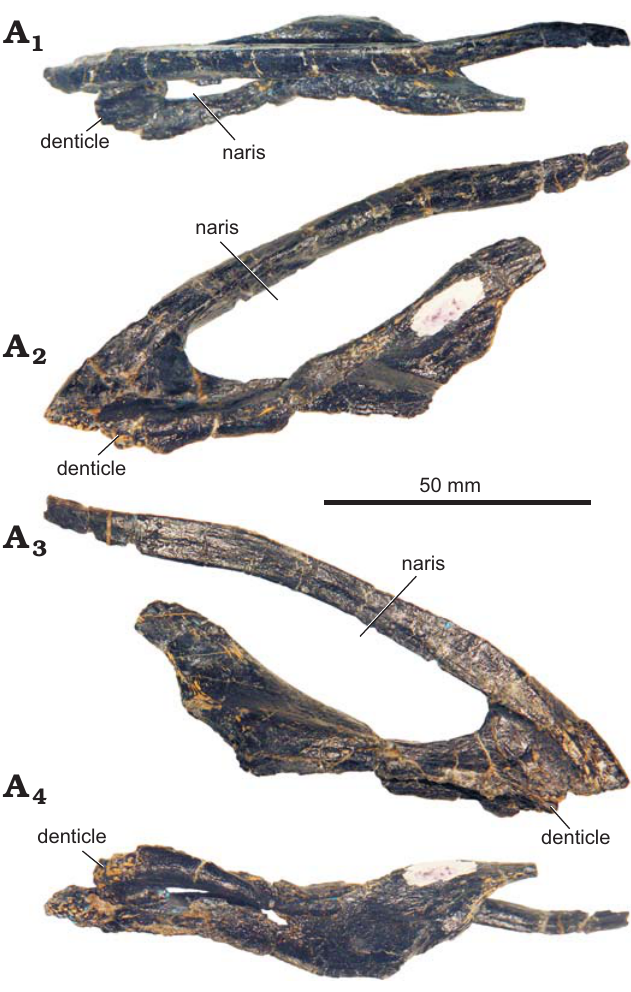
Fig. 7. Left premaxilla of stegosaur GPDM 178, near Giffen, Cascade County, Montana; in dorsal (A 1 ), lateral (A 2 ), medial (A 3 ), and ventral (A 4 )